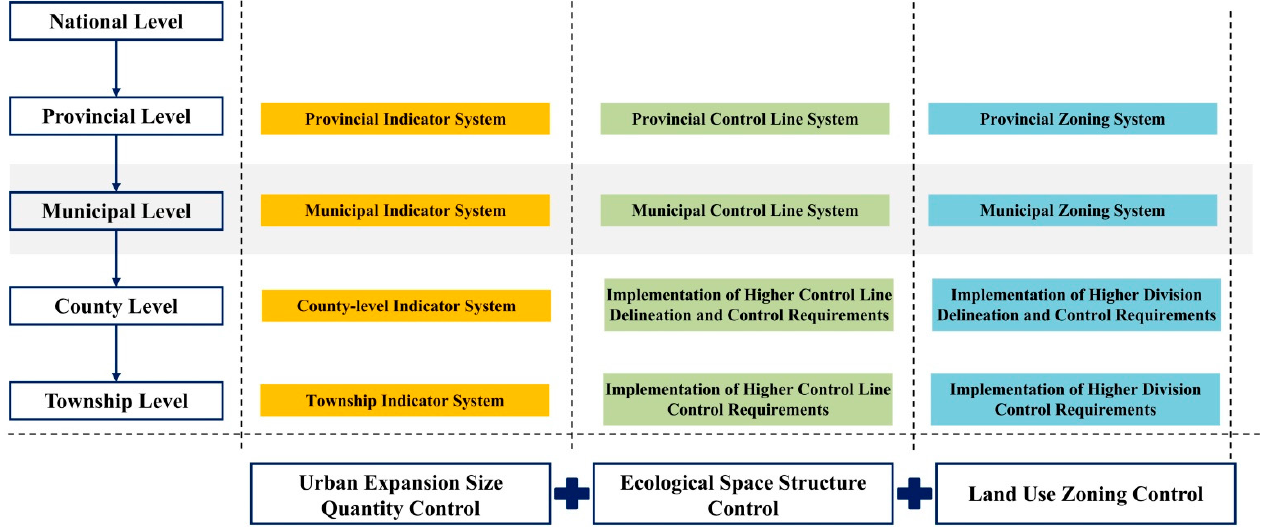
Figure 9. Territorial Spatial Planning Management and Control Transmission System.